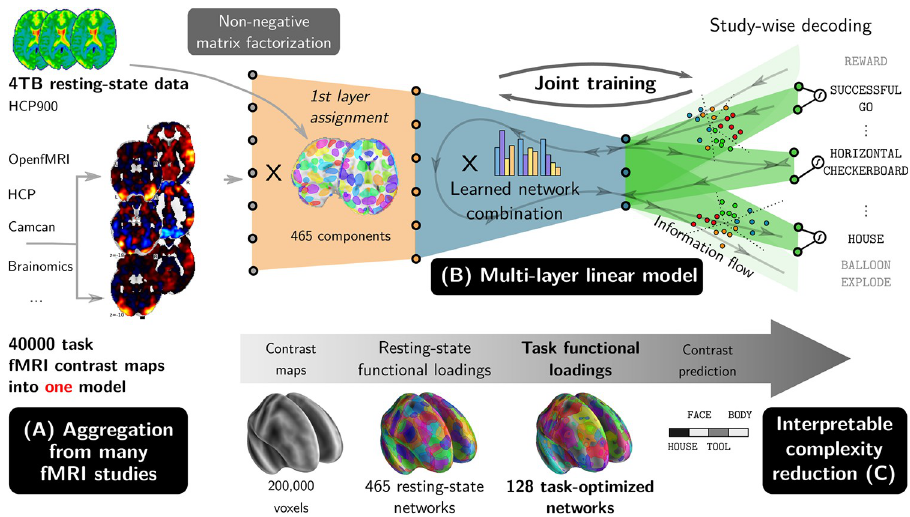
Fig 1. General description of our multi-study decoding approach. We perform inter-subject decoding using a shared three-layer model trained on multiple studies. An initial layer projects the input images from all studies onto functional networks learned on resting-state data. Then, a second layer combines the functional networks loadings into common meaningful cognitive subspaces that are used to perform decoding for each study in a third layer. The second and third layers are trained jointly, fostering transfer learning across